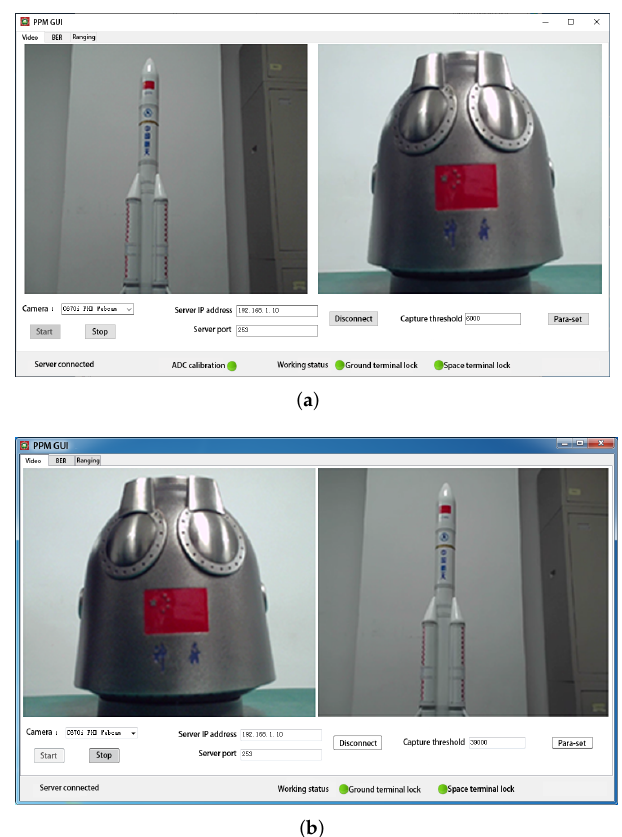
Figure 9. Video transmission experiment results: ( a ) Experimental results at the ground terminal. ( b ) Experimental results at the space terminal. The local video is on the left and the received video is on the right in each subplot.